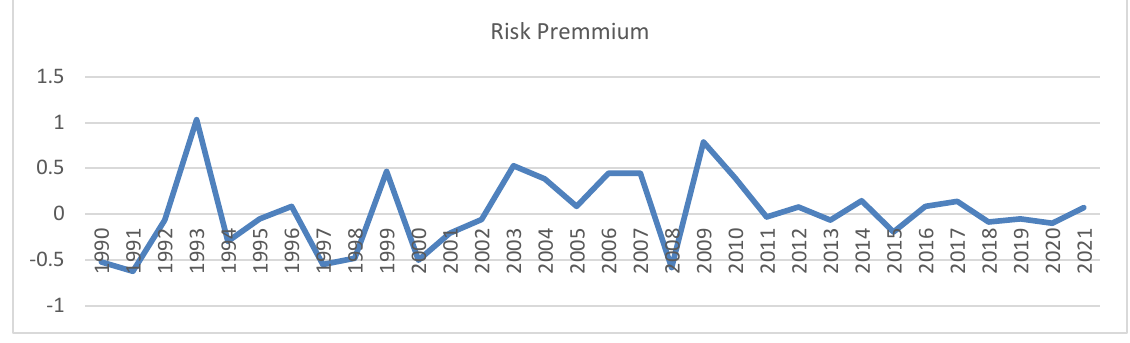
Figure 3: Annual Risk Premium for the Period 1990 – 2021